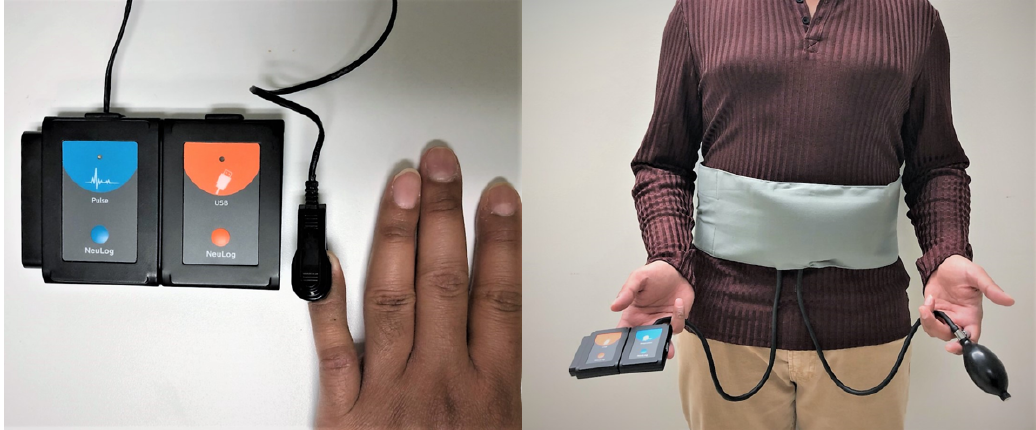
Figure 2. Neulog optical pulse sensor and respiration monitor belt logger sensor used to record PPG signals and breathing signals from the test subject as standard reference for heart-rate and breathing rate.